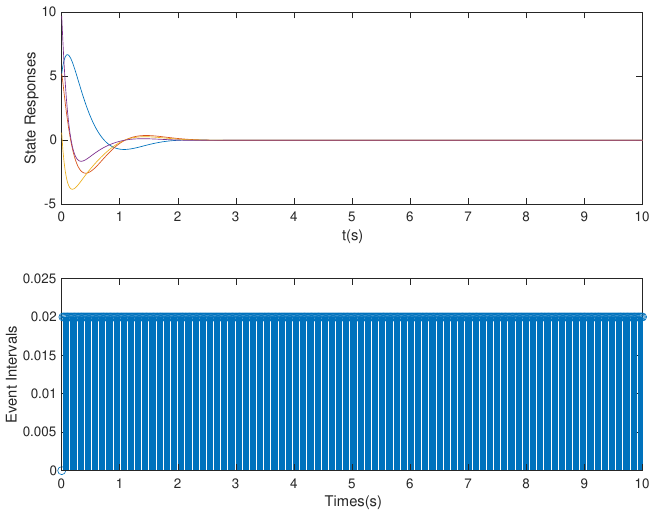
Figure 6. State responses and event intervals with DoS attacks for time-triggered predictive control